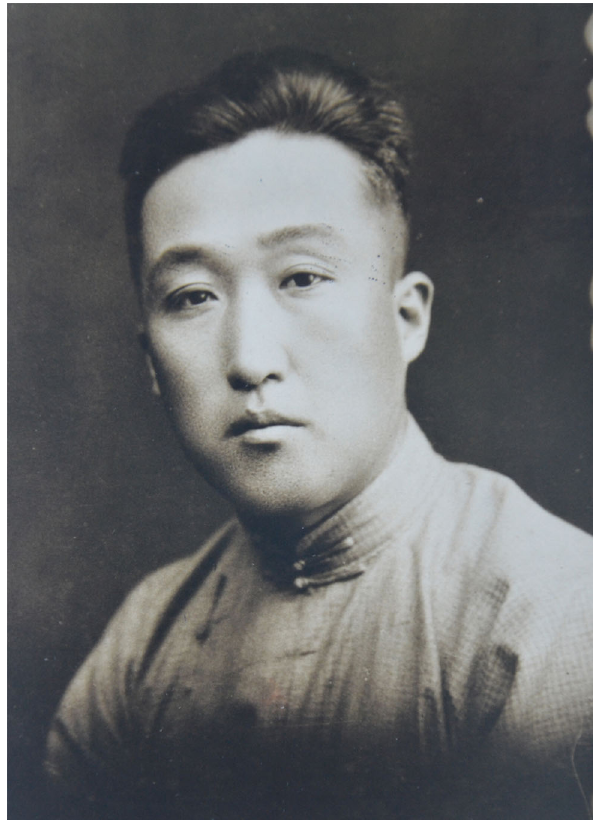
Figure 1. Chengru Feng (1896 – 1968).